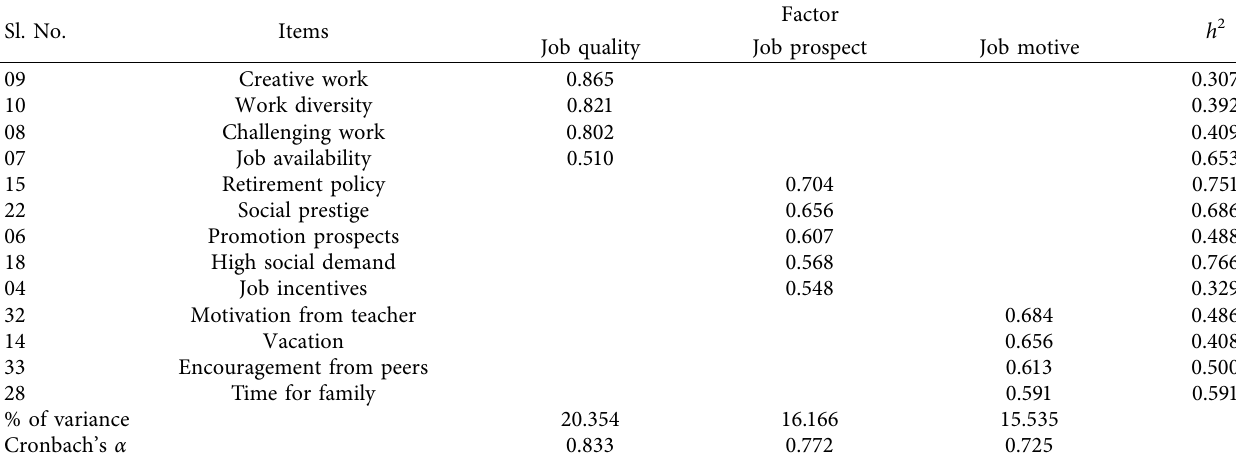
Table 3: Factor loadings, communalities (h 2 ), Cronbach’s alpha ( α ) and percentages of total variance for maximum likelihood extraction with varimax rotation ( n � 304). Sl.